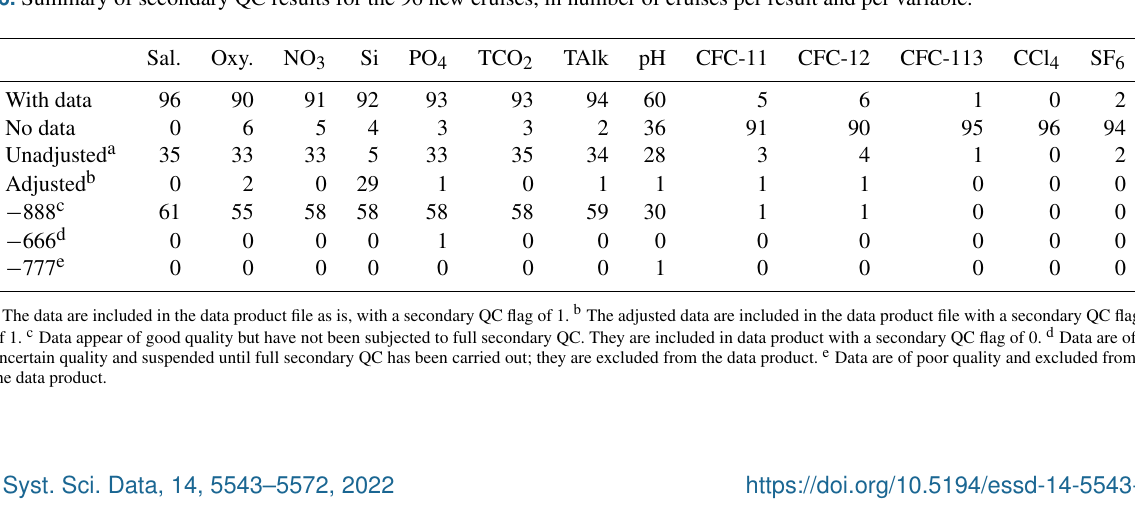
Table 6. Summary of secondary QC results for the 96 new cruises, in number of cruises per result and per variable. Sal.